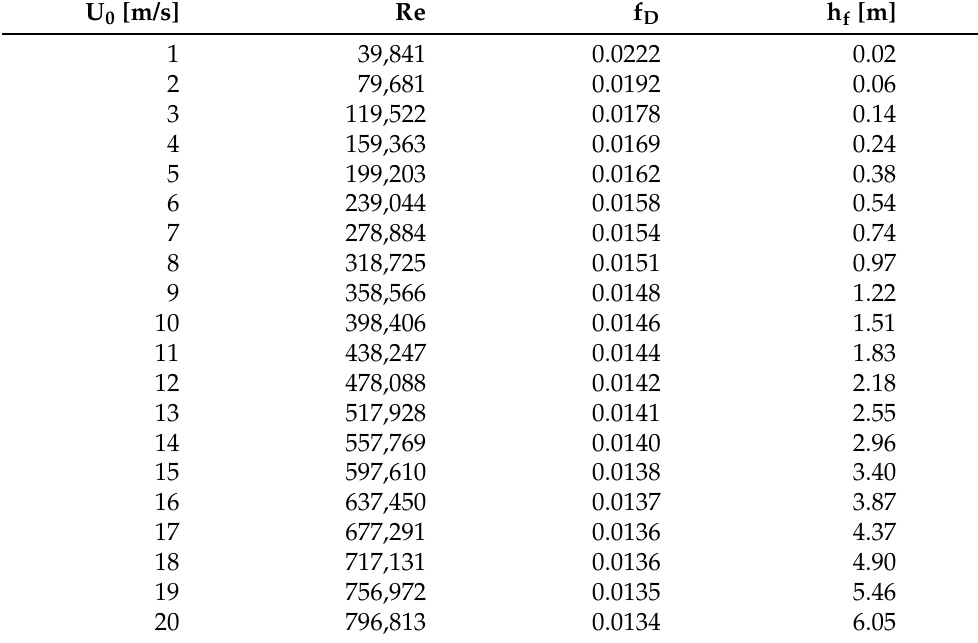
Table 2. Reynolds number, Darcy friction factor and major friction loss as a function of the input face